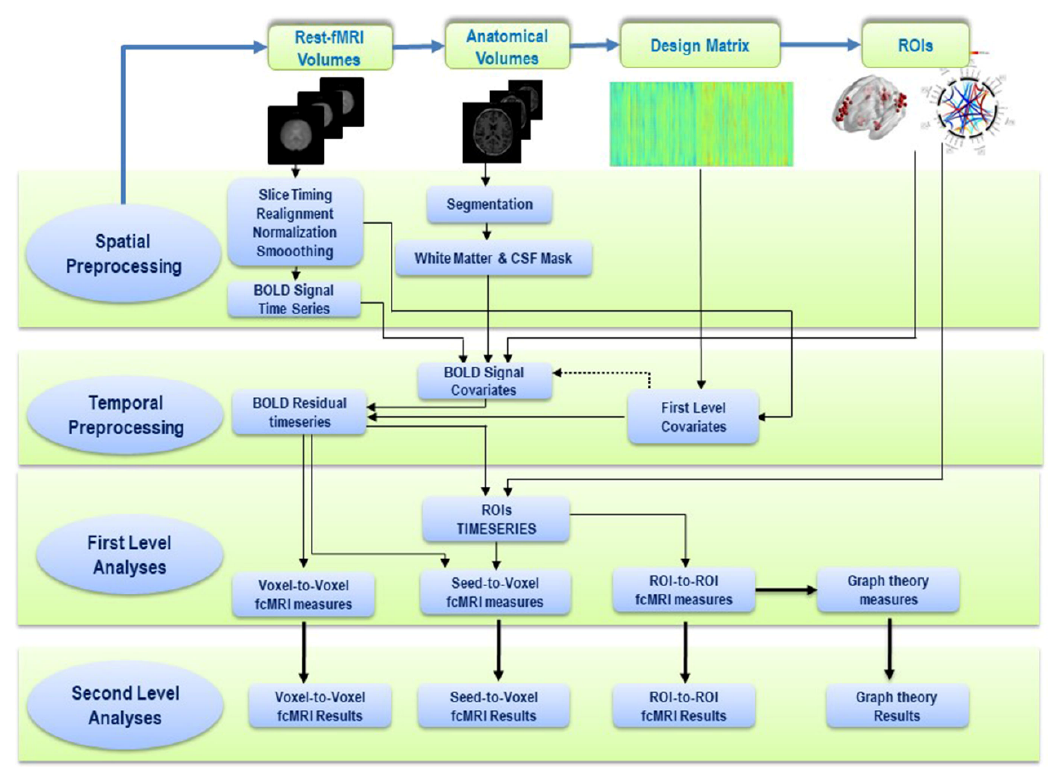
Figure 6. Rest-fMRI workflow pipeline for data extraction from MR images and data analysis using graph theory.